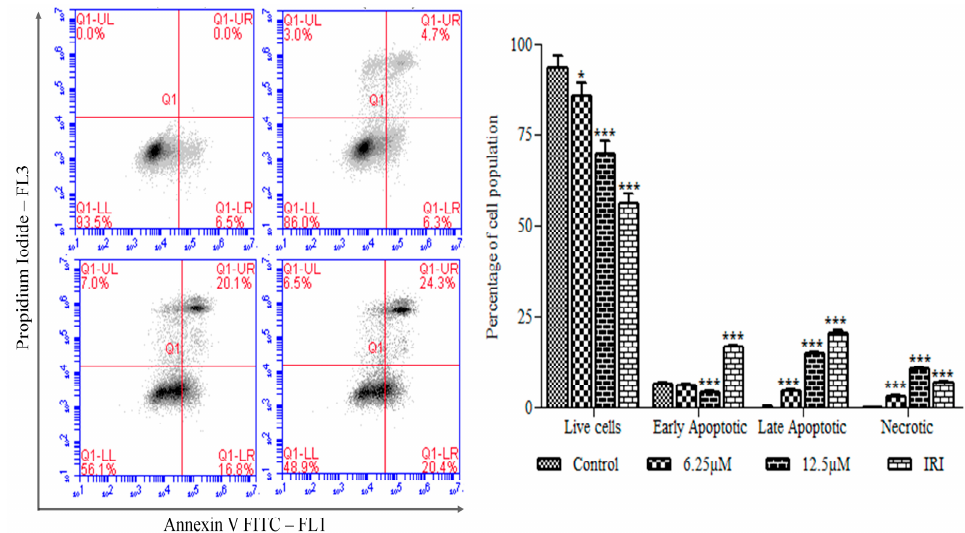
Figure 6. Effect of orientin on apoptosis in HT29 cells. Cells were treated with 6.25 and 12.5 µM orientin and irinotecan for 24 h, and the induction of cell apoptosis was examined by flow cytometry. LR represents early apoptotic cells and UR represents late apoptotic cells. Percentage of early and late apoptotic cells is shown in the bar graph. Data are shown as mean ± SD of three parallel independent experiments. * p < 0.05 and *** p < 0.001 vs. control.